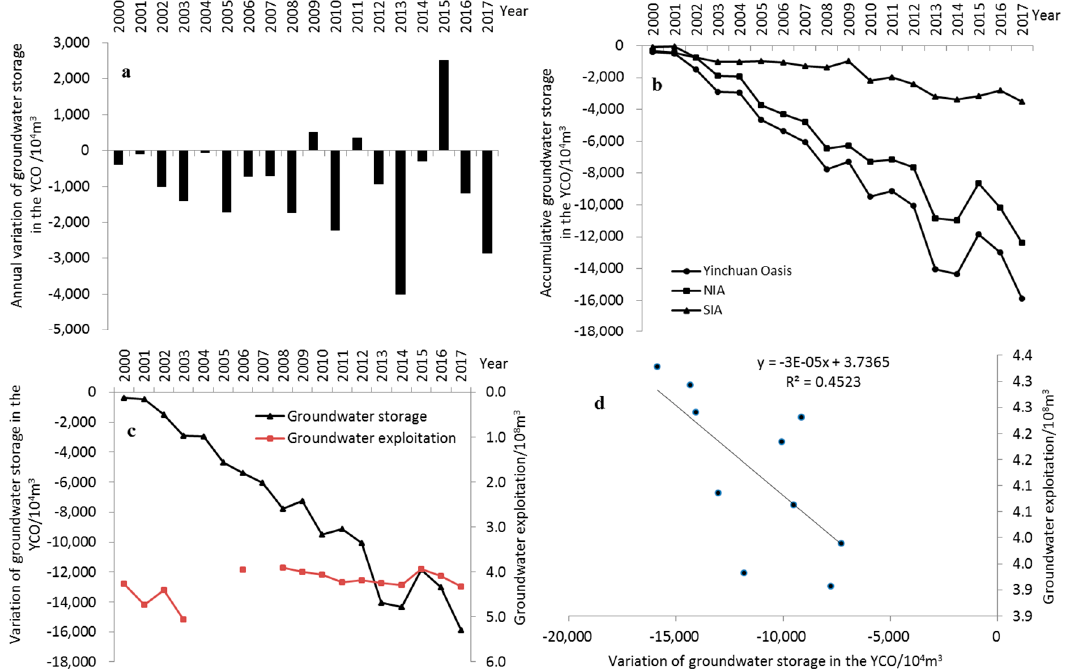
Figure 5. Groundwater storage variation and its relationship with groundwater exploitation: ( a ) Annual average groundwater storage variation, ( b ) accumulative groundwater storage variation, ( c ) variation of groundwater storage and groundwater exploitation, ( d ) correlation between groundwater storage variation and groundwater exploitation during 2008–2017. YCO: Yinchuan Oasis.